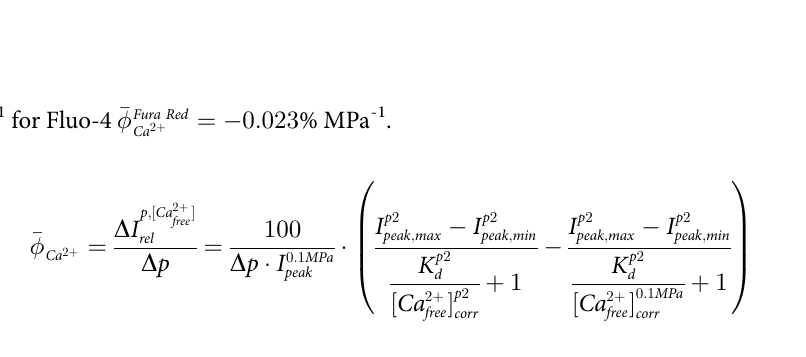
MPa -1 for Fluo-4 (cid:22) (cid:30) Fura Red